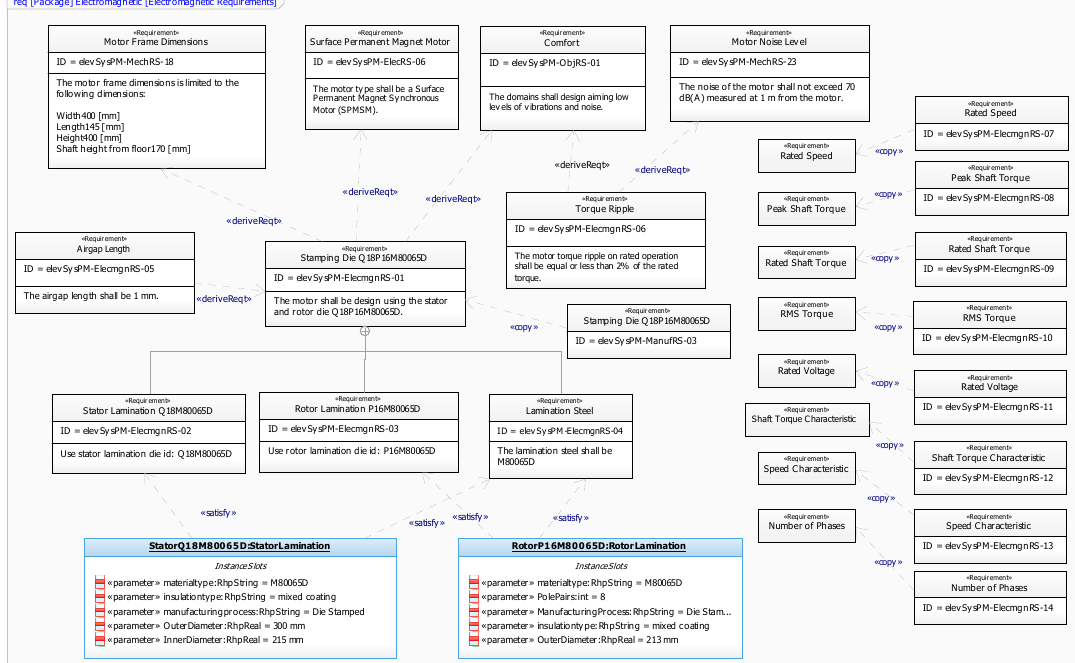
Figure 15. Electromagnetic requirements derivation.